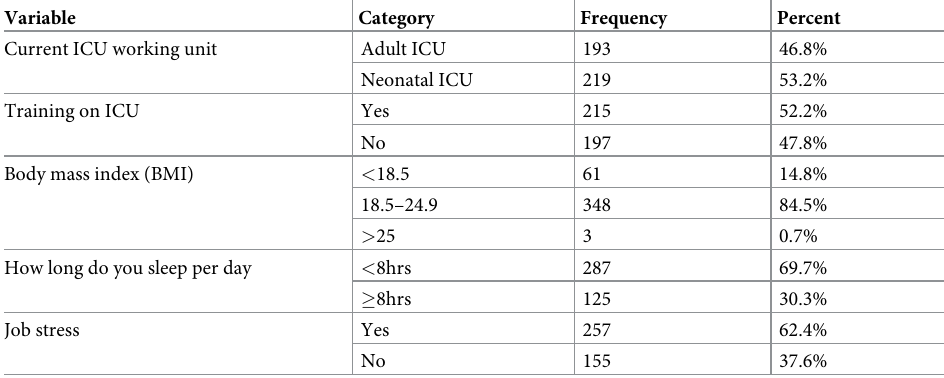
Table 2. Individual and psychosocial factors of low back pain among ICU nurses in Amhara region public hospi- tals, Amhara, Ethiopia